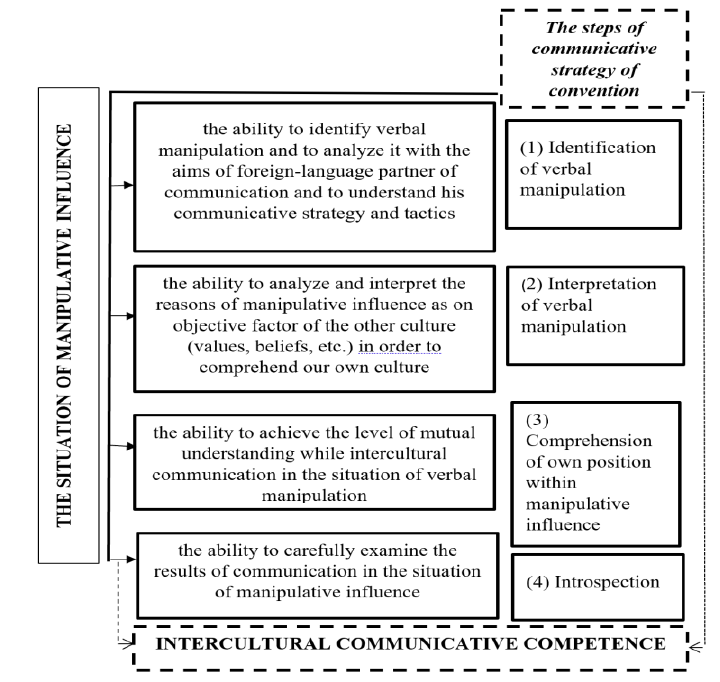
Figure 1. Descriptors of conventional (sub)competence in the context of the steps of realization of communicative strategy of